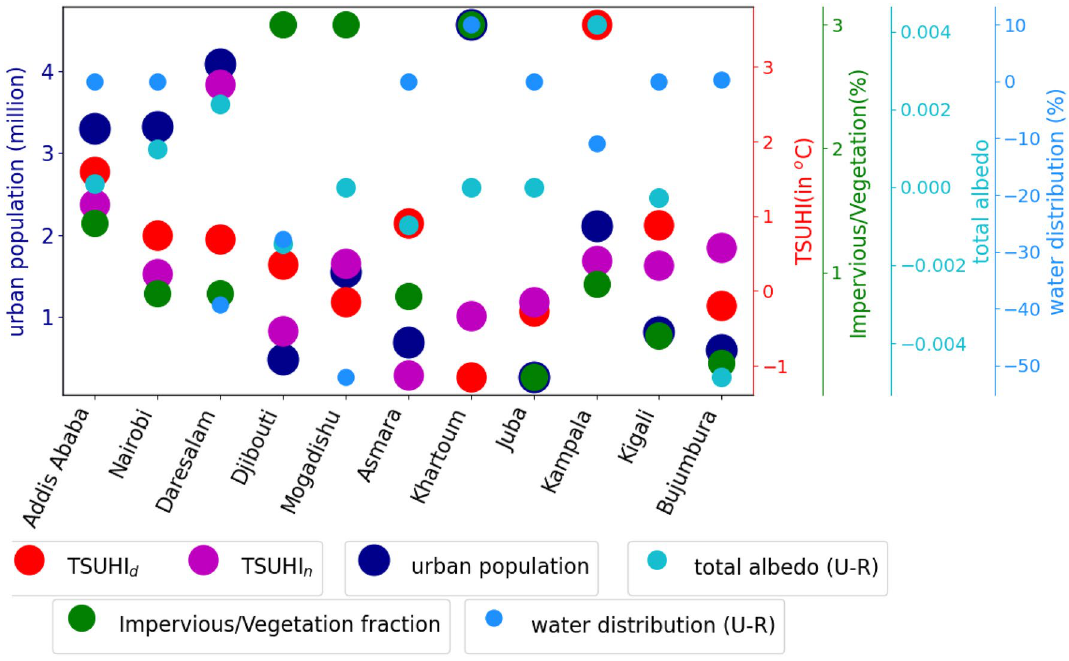
Figure 8. Urban factors affecting the surface urban heat islands in the Greater Horn of Africa (GHA) region. Different sizes and colors of circular objects are used to represent the different variables. The large circles with the red and pink colors represent tropical surface urban heat islands during the day and night respectively, the circles with a blue color represents the total urban population, the circles with aquamarine color represents the total albedo difference between urban and rural areas, the circles with the green colors represent the ratio of imperviousness to vegetation fractions in the urban area, and the light blue colors represent the surface water distribution difference between the urban and rural areas. The y-axis line colors and labels have similar colors with the circles representing each of the variables. The y-axis for TSUHI n , impervious/vegetation fractions, total albedo and water distribution are shown on the right side. The x-axis shows the corresponding capital cities in the east Africa